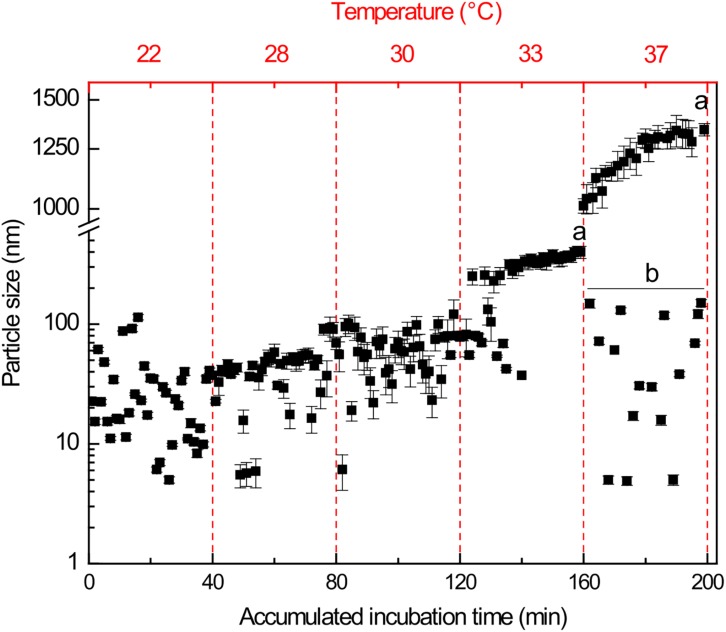
Particle size distribution of oligomeric states of dBlsA determined by DLS. The data shown are mean ± SD of two independent measurements from two different protein productions. Letter (a) represents significant difference (p < 0.05) between the first and last timepoint at any given temperature. Letter (b) represents significant difference (p < 0.05) between the mean of all values at the upper and the lower particle population (line).